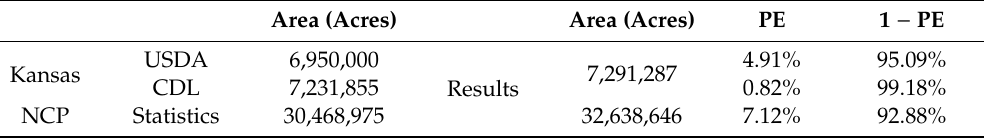
Table 8. Winter wheat distribution mapping evaluation at the state / regional